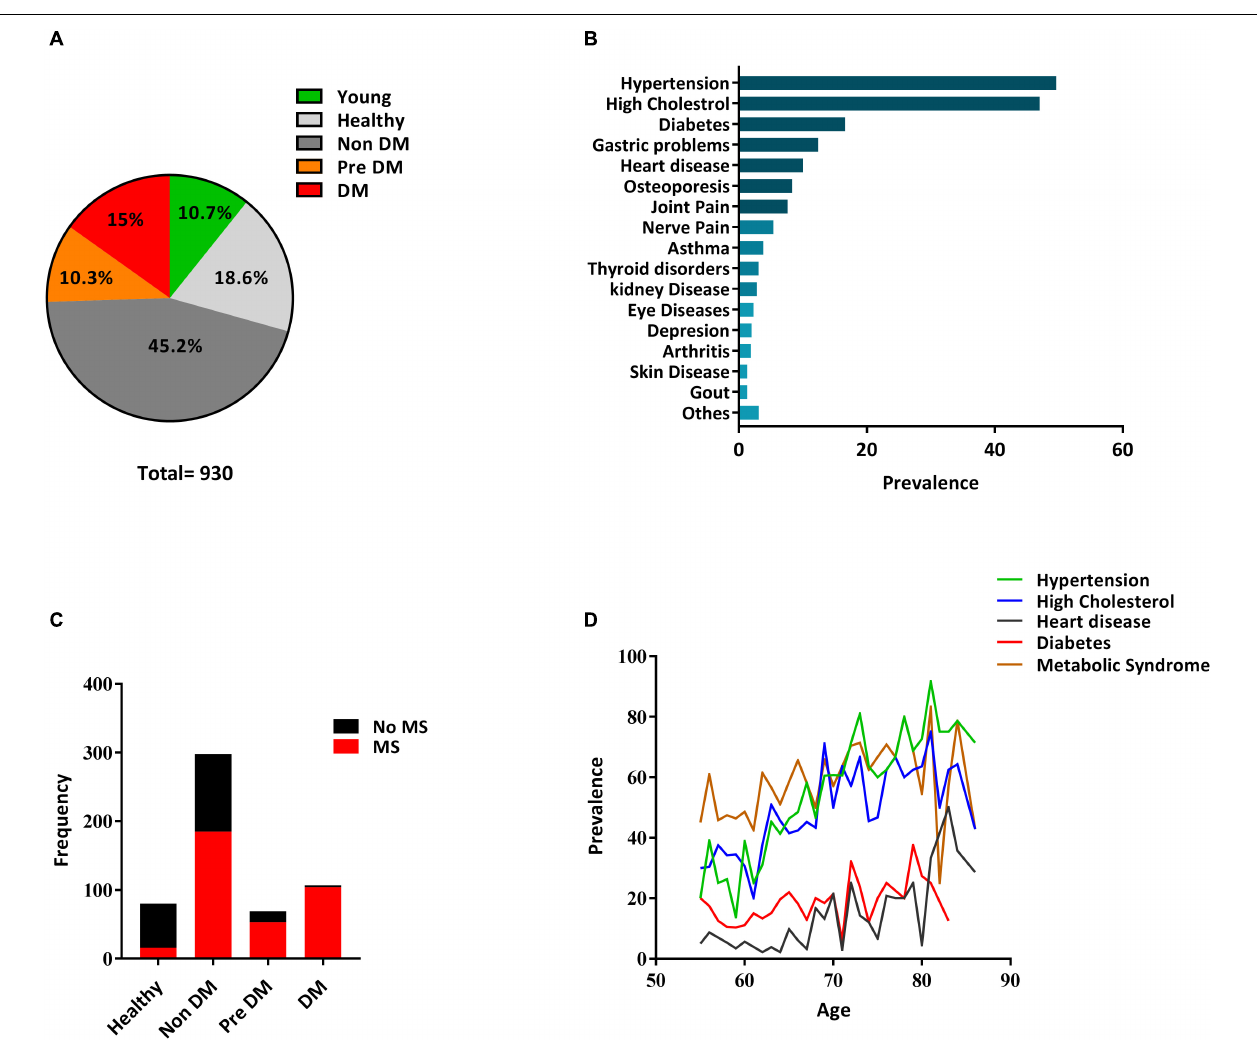
FIGURE 1 | Distribution of diabetes and other diseases in the SLAS cohort. (A) A pie chart indicating the percentage of the individual in each group. (B) Prevalence of confirmed medical conditions in the SLAS cohort. Others indicate [skin disease (1.67%), Gout (1.67%) chronic obstructive Pulmonary Disease (0.76%), Parkinson disease (0.3%), Anemia (1.2%), and Prostate cancer (1.07%)]. (C) Cases of metabolic syndrome in the four groups using the updated NCEPATP III [National Cholesterol Education Program (NCEP) Adult Treatment Panel III (ATP III)] criteria. The Proportion of Metabolic syndrome within Healthy, Non-DM, Pre DM, and DM group is 20, 62, 76.8, and 97.2%, respectively. (D) Age-dependent Prevalence of Diabetes, Hypertension, Heart Disease, High Cholesterol, and Metabolic Syndrome in the SLAS